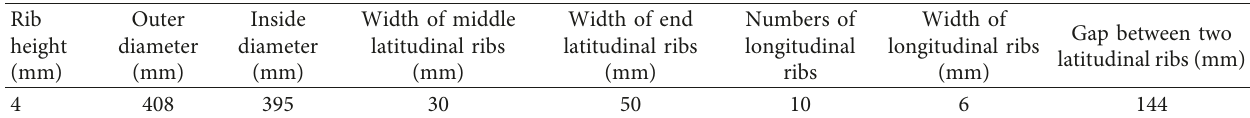
Table 8: Parameters of the sample with 4mm height ribs.